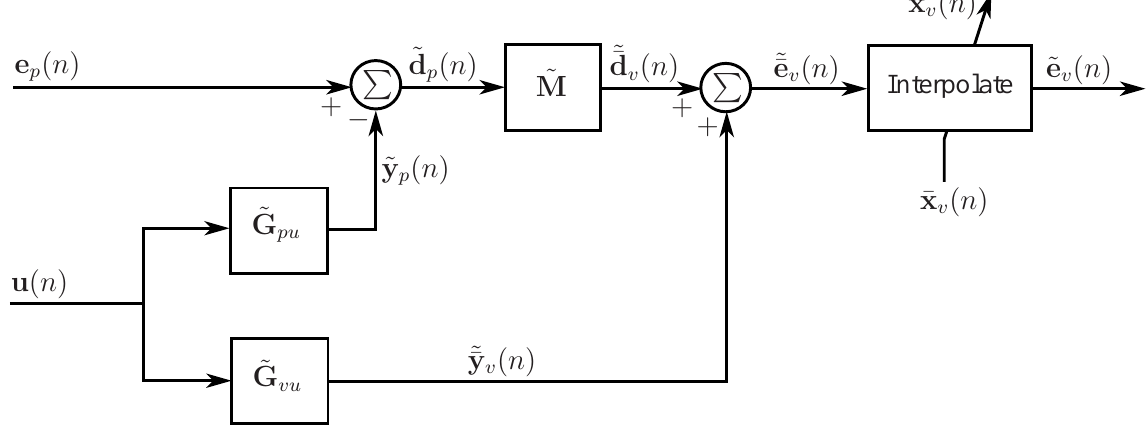
Figure 10 . Block diagram of the remote moving microphone